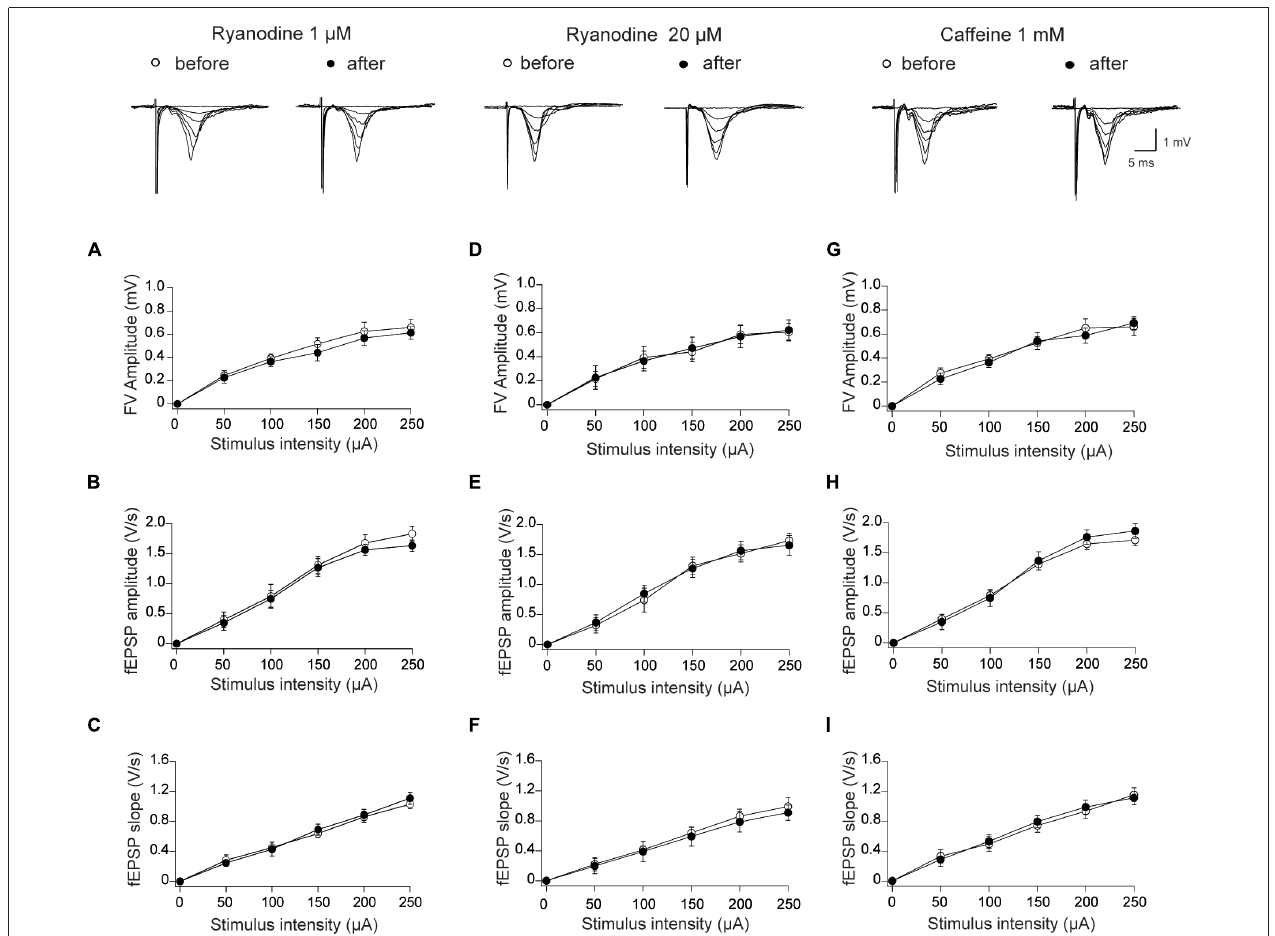
FIGURE 1 | Effects of stimulatory and inhibitory ryanodine concentrations and of caffeine on basal synaptic transmission in the CA3–CA1 hippocampal synapse. Left panels: slices were treated with 1 µ M ryanodine; representative field excitatory postsynaptic potential (fEPSP) traces registered before and 15 min after ryanodine addition are illustrated on top of the panels. (A) Fiber volley (FV) amplitude vs. stimulus intensity; (B) amplitude vs. stimulus intensity; (C) fEPSP slopes vs. stimulus intensity. Central panels: slices were treated with 20 µ M ryanodine; representative fEPSP traces registered before and 60 min after ryanodine addition are illustrated on top. (D) FV amplitude vs. stimulus intensity; (E) fEPSP amplitude vs. stimulus intensity; (F) fEPSP slopes vs. stimulus intensity. Right Panels: slices were treated with 1 mM caffeine; representative fEPSP traces registered before and 15 min after caffeine addition are illustrated on top. (G) FV amplitude vs. stimulus intensity; (H) fEPSP amplitude vs. stimulus intensity; (I) fEPSP slopes vs. stimulus intensity. Values represent Mean ± SEM; (12, 3). The first number in parentheses indicates the number of hippocampal slices and the second the number of animals used. Statistical significance of values was assessed by Mann-Whitney test ( p > 0.05 in all